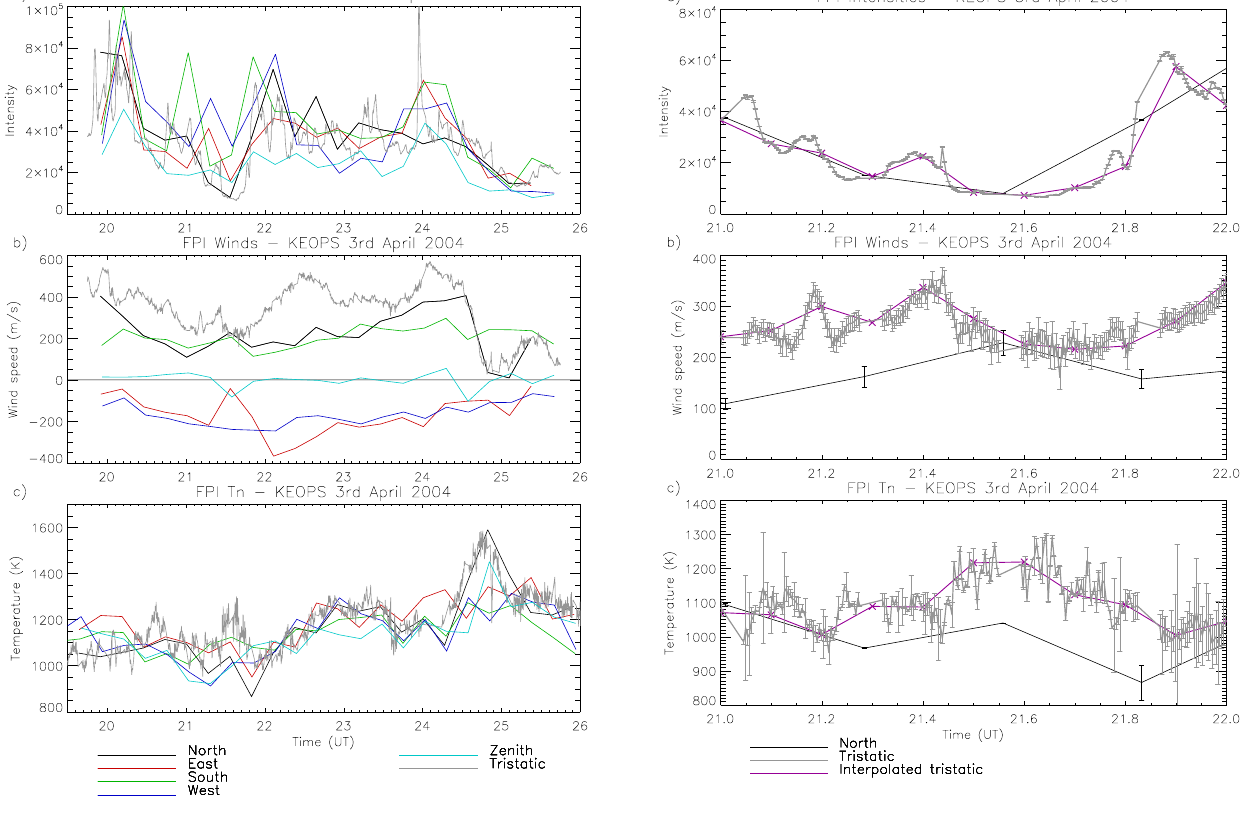
Fig. 2. FPI data from KEOPS on 3 April 2004 (a) intensities, (b) winds, and (c) temperatures.